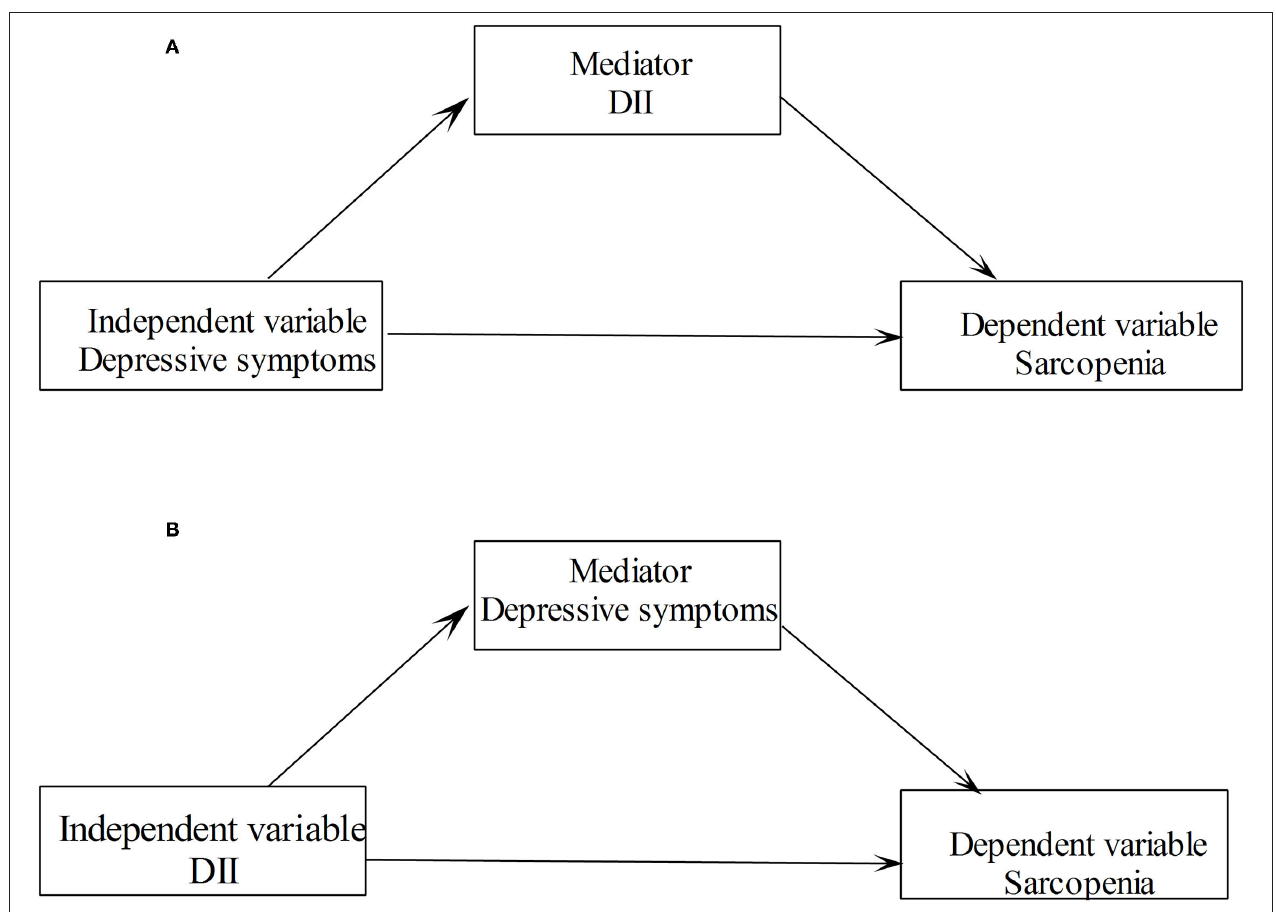
FIGURE 1 | Path diagram of the mediation analysis models.